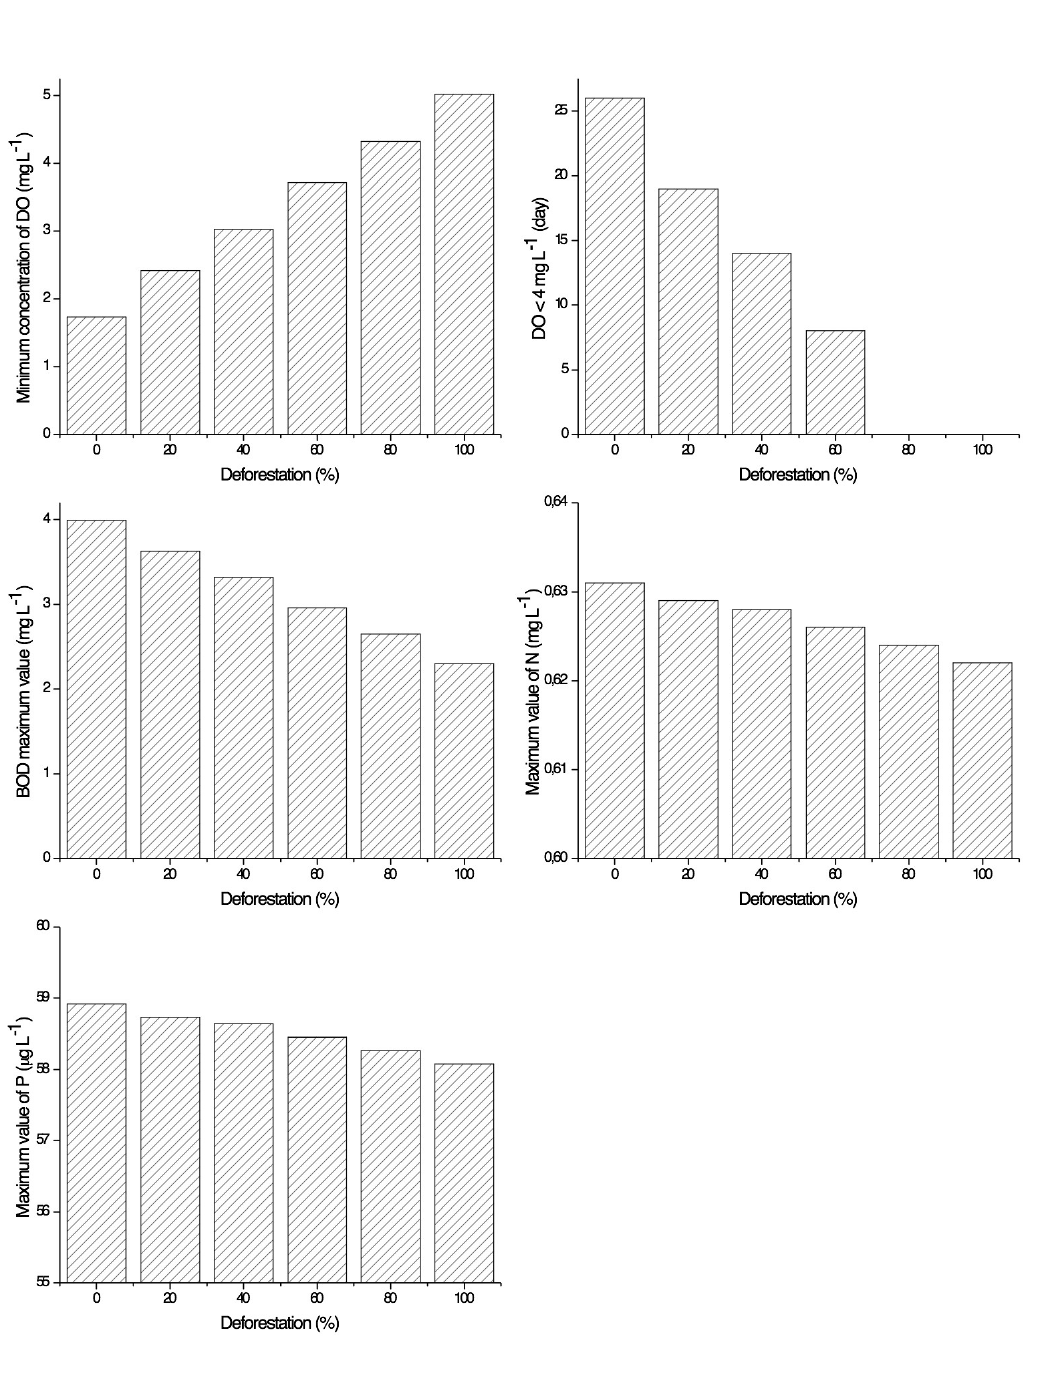
Figure 2. The effects of deforestation over: the minimal concentration of dissolved oxygen; the time with dissolved concentration of oxygen less than 4 mg L -1 ; and the maximum concentration of BOD, nitrogen and phosphorous. Bianchini Junior & Cunha-Santino